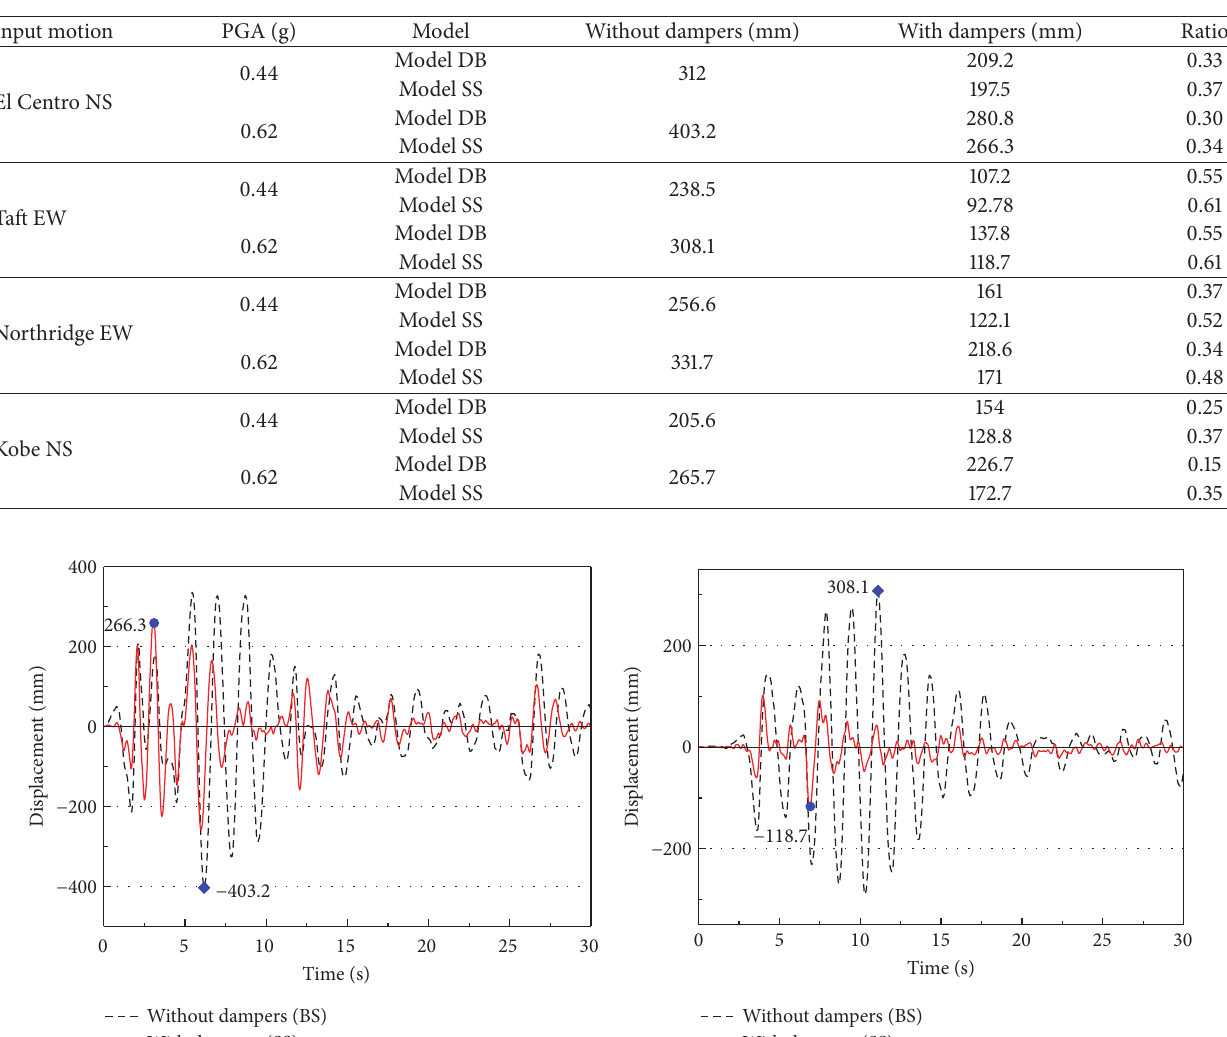
Table 6: Maximum displacement at the top of the structure.